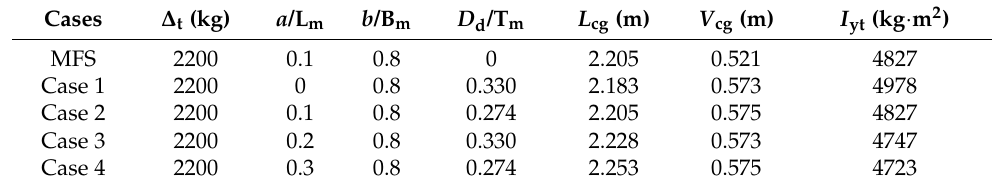
Table 11. The main geometric parameters of the real ‐ scale MFS and cases 1–4 under condition two.